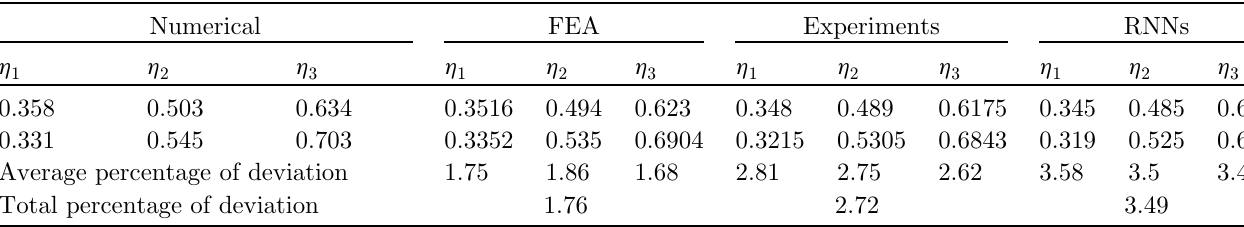
Table 3. Comparison of results for relative crack locations ( h ) with various methods. Numerical